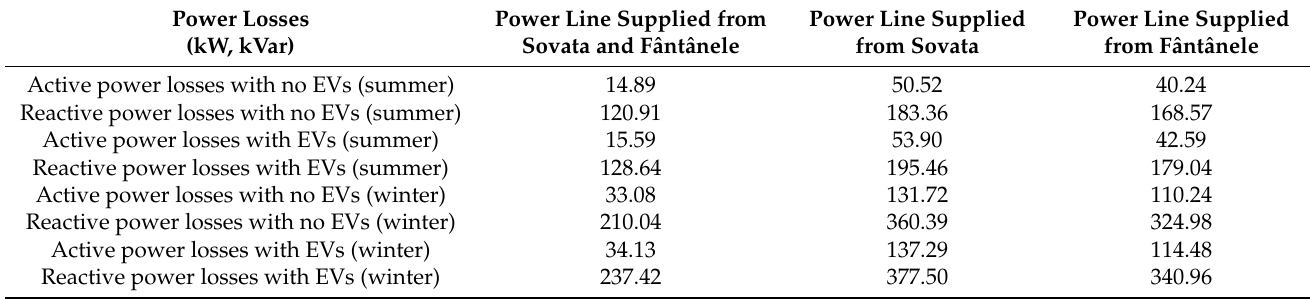
Table 13. Power losses at 6:00 (scenario 2).